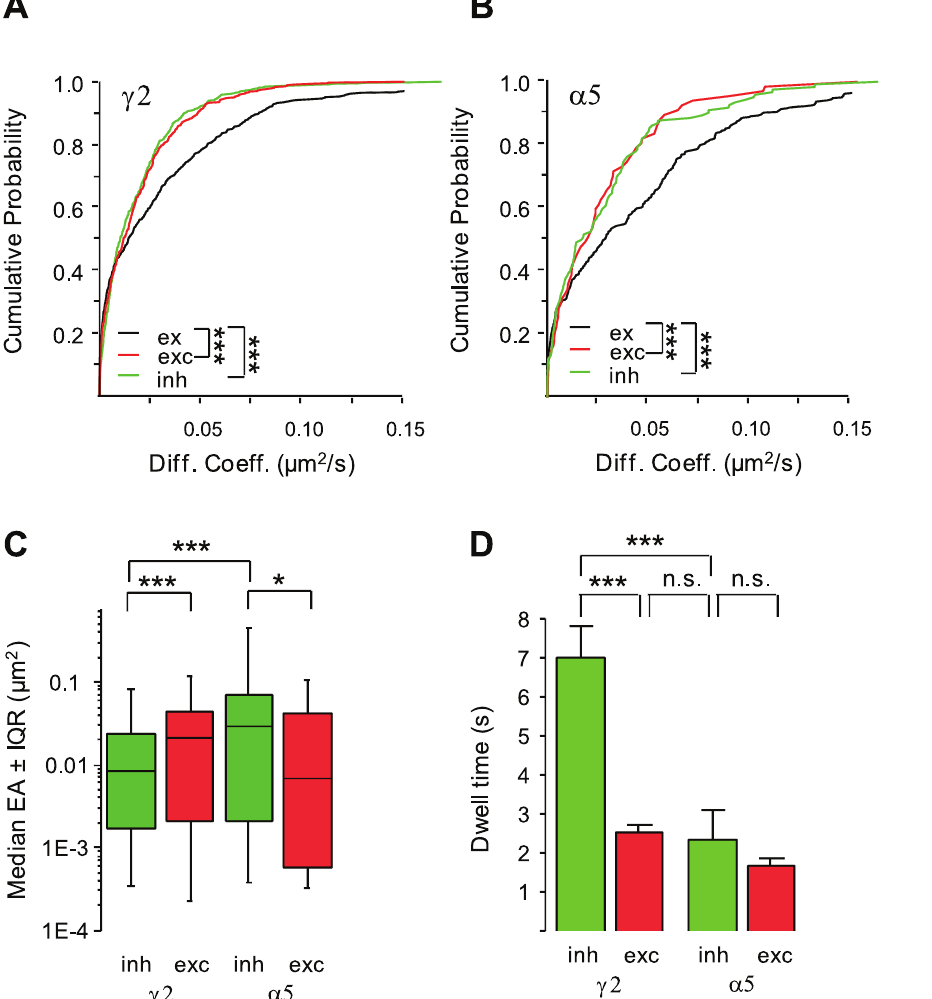
Figure 3. Comparison of the diffusion properties of GABA A R c 2 and a 5 in inhibitory and excitatory synapses. (A–B) Cumulative probabilities of diffusion coefficients of c 2 and a 5 in inhibitory (green, inh) and excitatory synapses (red, exc) vs . the extrasynaptic membrane (black, ex). Note the reduced diffusion of c 2 and a 5 in inhibitory and excitatory synapses as compared to the extrasynaptic membrane (KS test, ***p , 10 2 3 ). (C–D) Decreased explored surface area (C, median EA 6 25%–75% IQR; KS test, *p , 5 6 10 2 2 ; ***p , 10 2 3 ) and dwell time (D, mean 6 SEM; t-test, ns: not significant, ***p , 10 2 3 ) for c 2 in inhibitory (green) vs . excitatory (red) synapses. In contrast, the dwell time of a 5 did not significantly differ in inhibitory (green) and in excitatory (red)